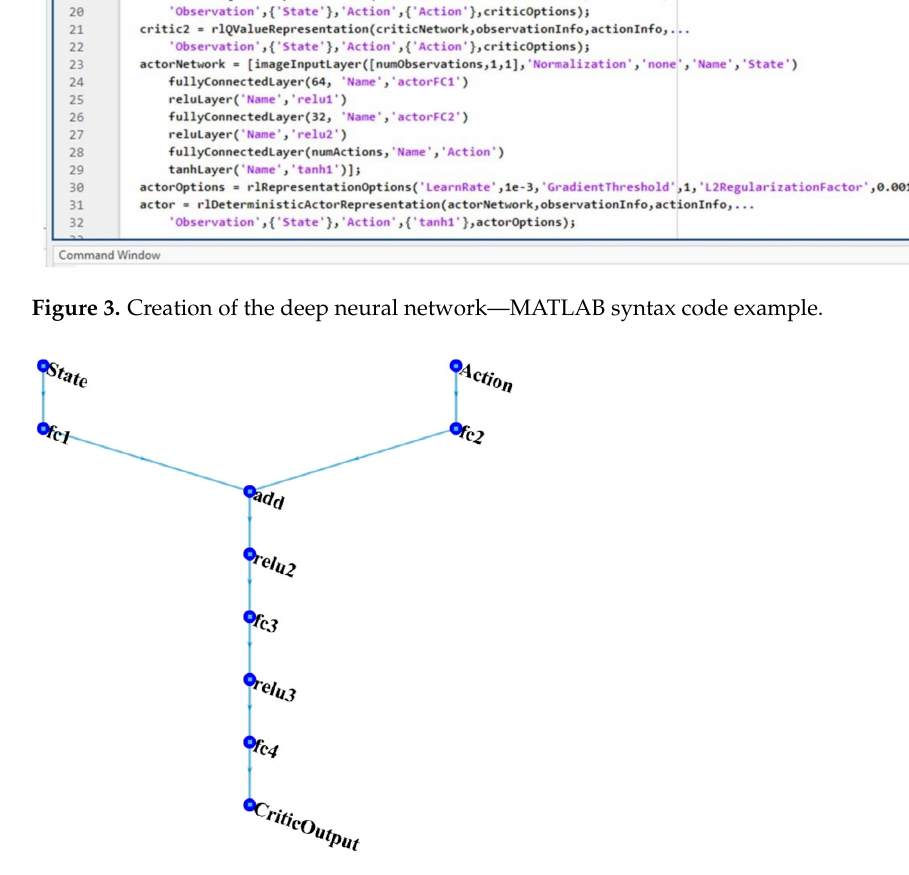
Figure 4. Representation of the deep neural network for the RL-TD3 agent.